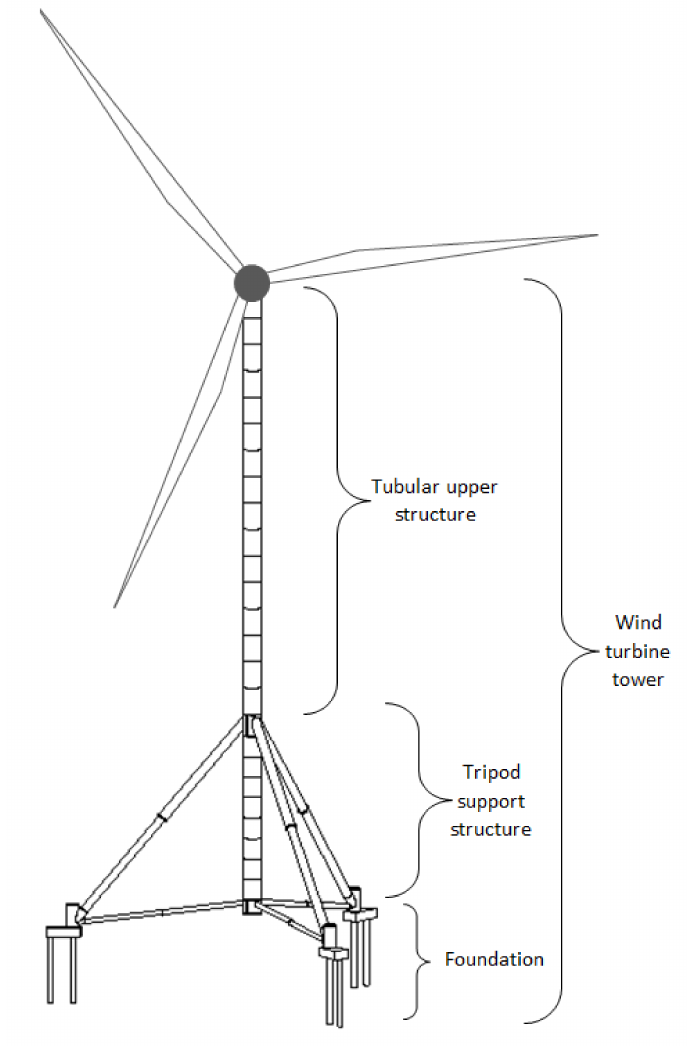
Figure 1. Main parts of proposed wind turbine tower